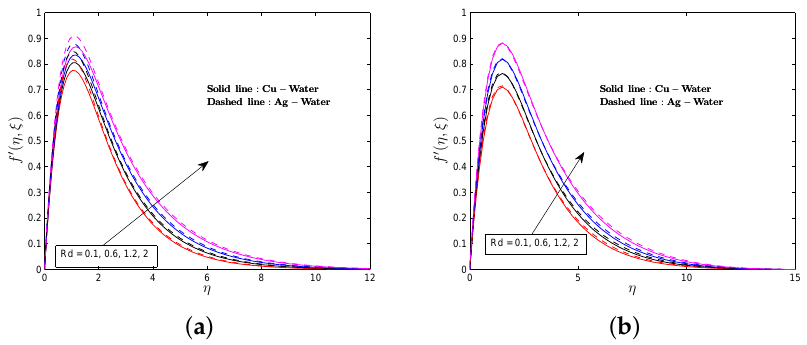
Figure 7. Velocity profiles for various values Rd . ( a ) vertical plate; ( b ) horizontal